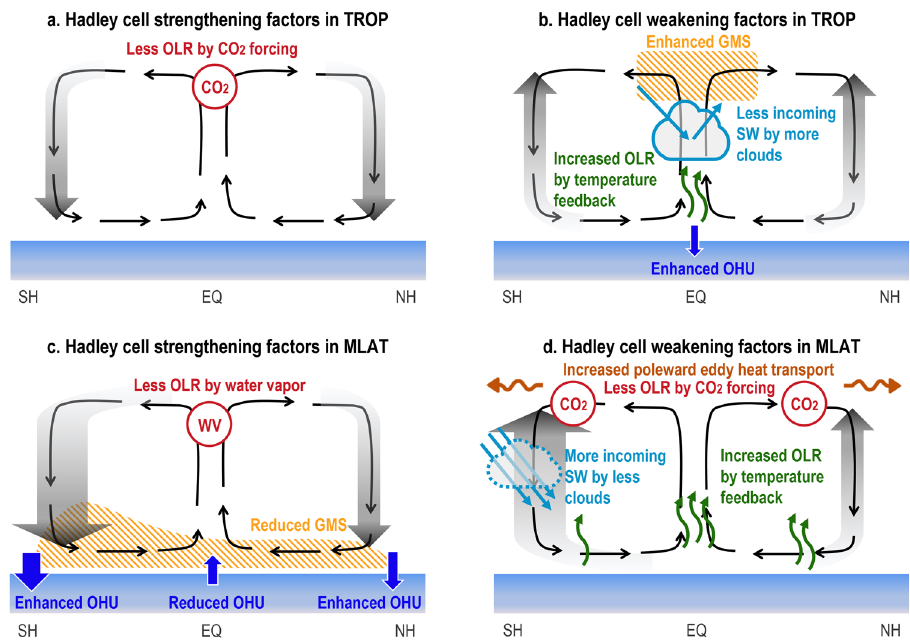
Fig. 7 Schematic summary of the physical processes explaining the distinct HC responses to different CO 2 forcings. a Main factor that causes HC strengthening in response to TROP forcing is the direct CO 2 forcing that enhances the meridional atmospheric energy gradient. b HC weakening in response to TROP forcing is caused by the temperature feedback, shortwave cloud feedback, enhanced gross moist stability, and enhanced heat uptake by the equatorial ocean. c HC strengthening in response to MLAT forcing is caused by the water vapor feedback, reduced gross moist stability, and increased ocean heat uptake by the extratropical oceans and decreased ocean heat uptake by the equatorial ocean. d HC weakening in response to the direct CO 2 forcing in MLAT is ampli fi ed by enhanced poleward eddy heat transport, shortwave cloud feedback, and temperature